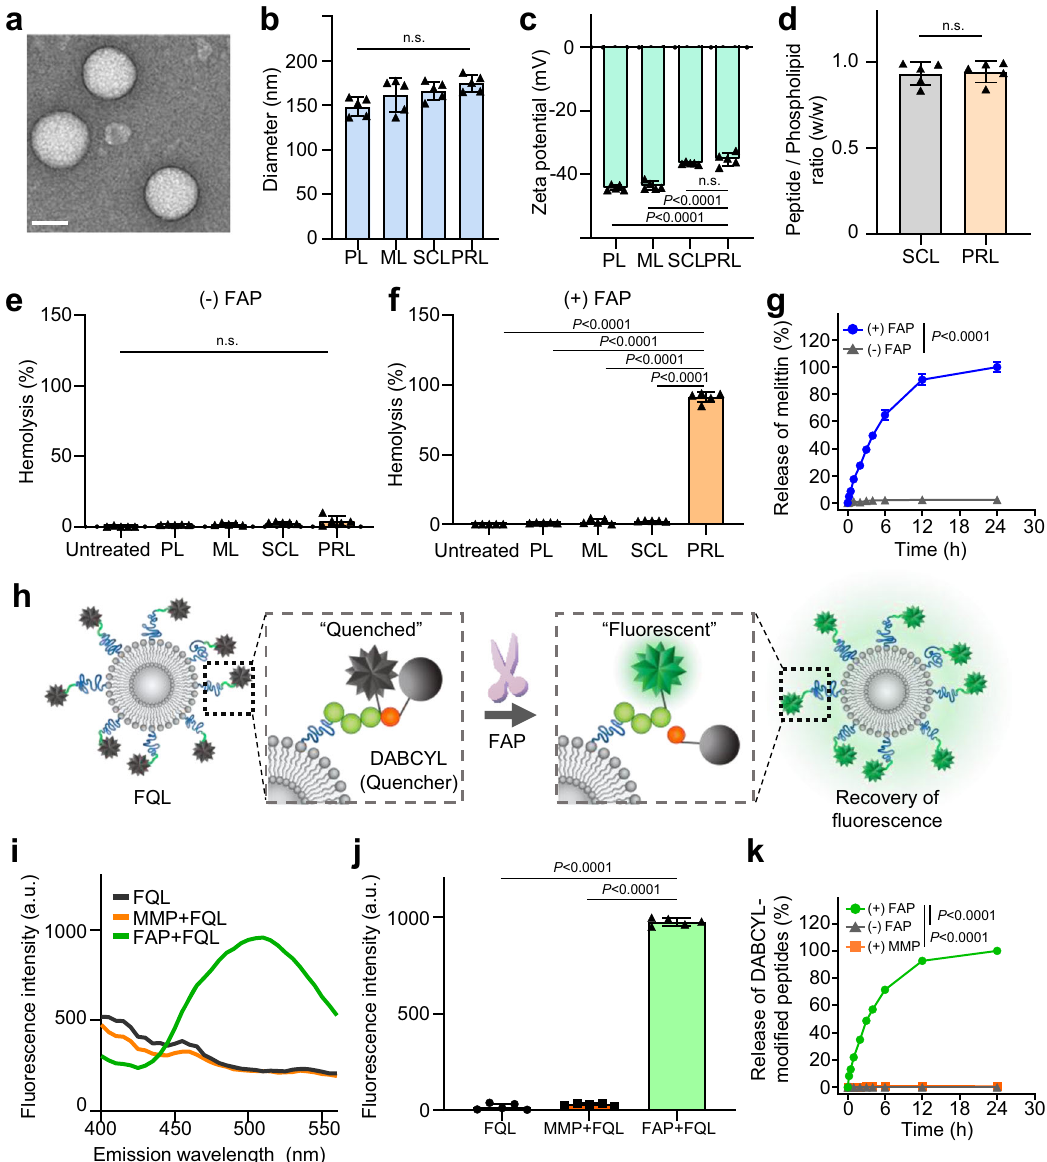
In vivo anti fi brotic effect . The experimental scheme for assessing the anti fi brotic ef fi cacy of various liposome formulations in a BDL animal model is illustrated in Fig. 5a. Anti fi brotic ef fi cacy was evaluated using histological, biochemical, and serological analyses. Fibrotic regions of the liver were visualized by Masson ’ s trichrome method, which stains collagen fi bers blue and normal tissues red. Masson ’ s trichrome staining showed fi brotic regions in the livers of mice treated with ML, PL, or SCL. In contrast, images of whole livers from mice treated with PRL showed fewer fi brotic (blue-stained) regions compared with livers from mice treated with any other liposome formulation (Fig. 5b). Similar to the Masson ’ s trichrome staining results, hematoxyllin and eosin (H&E) staining revealed tissue damage in the vicinity of blood vessels for groups treated with PL, ML, or SCL, but not PRL (Fig. 5b). A quantitative analysis of images revealed that Masson ’ s trichrome-stained liver tissues from mice treated with PRL showed signi fi cantly fewer fi brotic regions than those from other treatment groups (Fig. 5c). Applying the METAVIR F